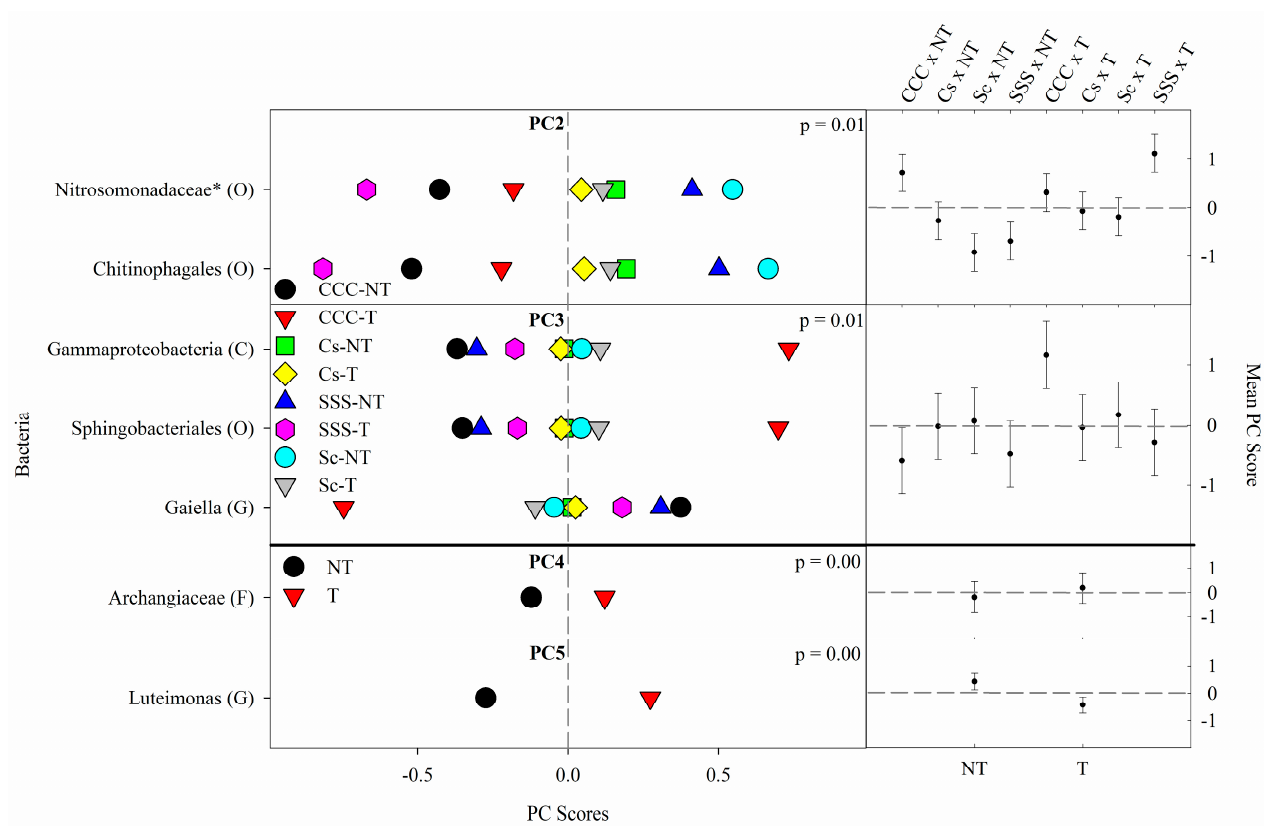
Figure 2. Mean bacterial principal component scores (PC) following 20 years of rotation and tillage treatments. Right panels show the bacterial mean PC score for the crop rotation × tillage interaction for PC2 and PC3 and a tillage effect for PC4 and PC5 based on the analysis of variance (ANOVA); error bars represent standard errors of the mean PC scores. Left panels show relative abundances (RAs) for each bacterial indicator ASVs by crop rotation × tillage and tillage. The crop rotation × tillage interaction for PC2 and PC3 is shown as CCC-NT, continuous corn, and no-till; CCC-T, continuous corn, and chisel tillage; Cs-NT, corn phase of the corn-soybean rotation and no-till; Cs-T, corn phase of the corn-soybean rotation and chisel tillage; Sc-NT, soybean phase of the corn-soybean rotation and no-till; Sc-T, soybean phase of the corn-soybean rotation and chisel tillage; SSS-NT, continuous soybean and no-till; SSS-T, continuous soybean and chisel tillage. The tillage main effect for PC4 and PC5 is shown as NT, no-till; T, chisel tillage. For each taxon, the response of each ASV was calculated as the mean PC score multiplied by the PC loading score of a given ASV. The y-axes show the name of the ASV’s most explanatory taxonomic rank in parentheses (P, phylum; C, class; O, order; F, family; G, genus; S, species). The “*” after an ASV means it is uncultured.